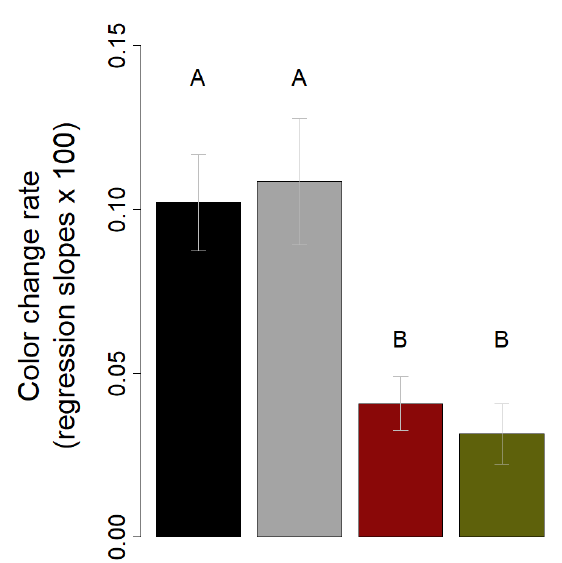
FIGURE 4 | Mean and SE representing color change rates for each population of Crenuchus spilurus . Colors represent populations as in Fig. 1. Black and grey bars represent populations of the Negro lineage, red and brown bars represent populations of the Amazonas lineage. Letters represent groupings observed in Tukey’s HSD test.